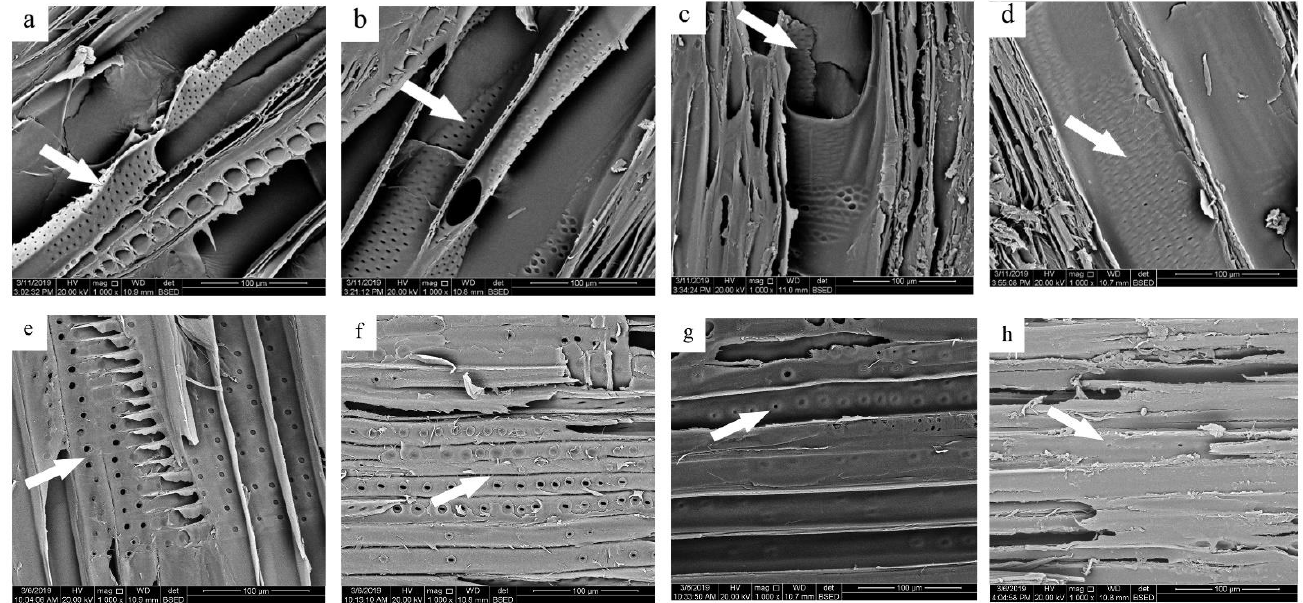
Figure 4. Microstructures of longitudinal sections of control poplar wood ( a ), PW17 ( b ), PW35 ( c ), and PW51 ( d ); microstructures of longitudinal sections of control Chinese fir wood ( e ), SW23 ( f ), SW45 ( g ), and SW75 ( h ).